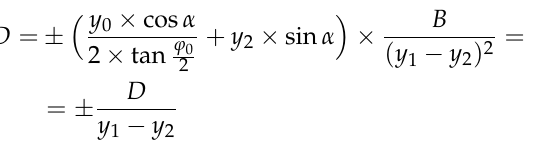
and y 2 max min